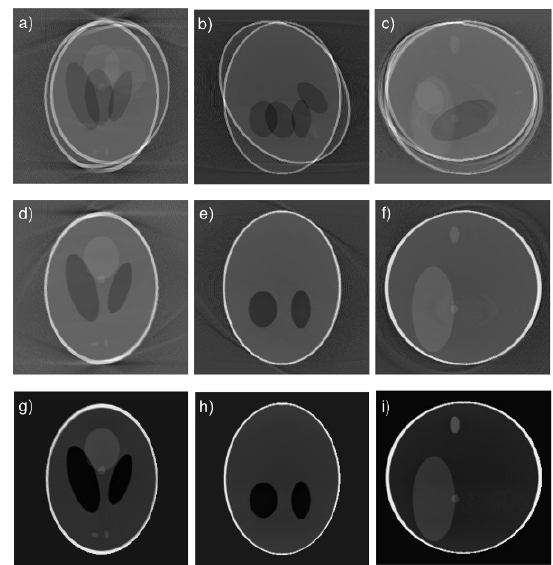
Figure 20. (a–c) axial, coronal and sagittal slices for combined rota- tionalandtranslationalmotioncorruptedcase; (d–f)same slices after motion compensation; (g–i) same slices for motion free ideal case.